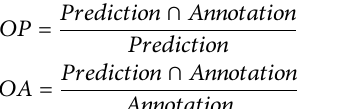
Bolded numbers indicate highest score obtained under each